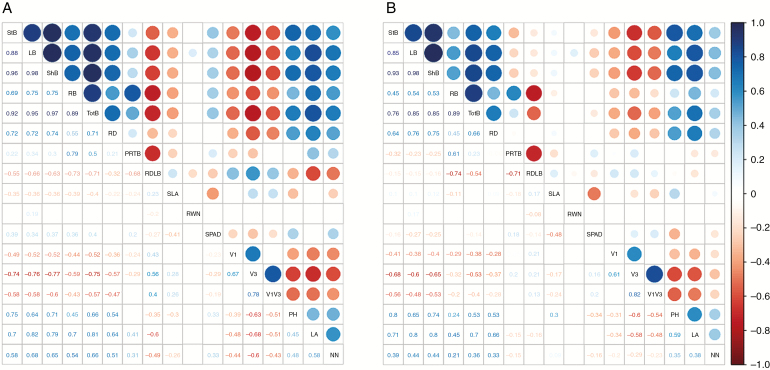
Phenotypic correlation among traits. (A) Irrigated. (B) Drought. Only correlations significant at P < 0.05 are shown. BLD, soil bulk density; LA, leaf area; LB, leaf biomass; NN, nodule number; PH, plant height; PRTB, proportion of roots to total biomass; PTAC, Priestley–Taylor α coefficient; RB, root biomass; RD, root depth; ShB, shoot biomass; SLA, specific leaf area; StB, stem biomass; SPAD, chlorophyll content; Temp, temperature; RDLB, root depth length per biomass; TotB, total biomass; V1, time to emergence; V3, time from planting to V3; V1V3, time from emergence to V3. The colours represent that the values of the correlation coefficient according to the heat map to the right of the graph. The size of of the circles is proportional to the absolute value of the correlation coefficients.